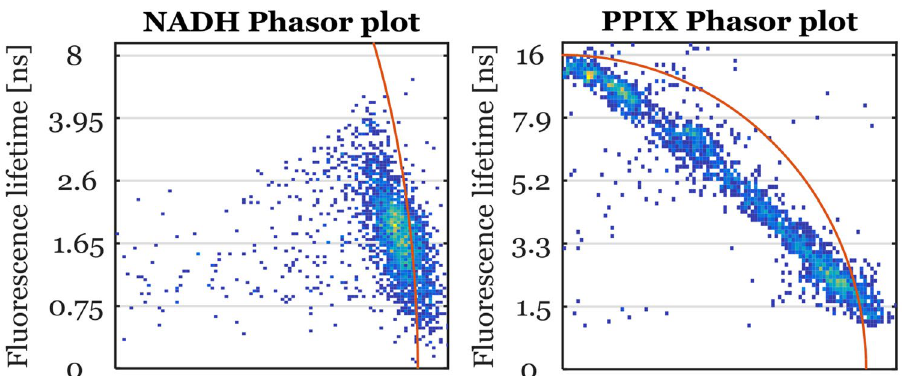
Figure 6. Cumulated phasor plot for NADH and PPIX fluorescence for all 42 tissue samples—The point clouds show the distribution of fluorescence lifetimes compared to the universal circle (in red). Points lying on the universal circle indicate a single-exponential fluorescence decay. However, NADH and PPIX show an elongated cloud which is indicative for a multiexponential decay. For NADH, this is due to the mixture of free and